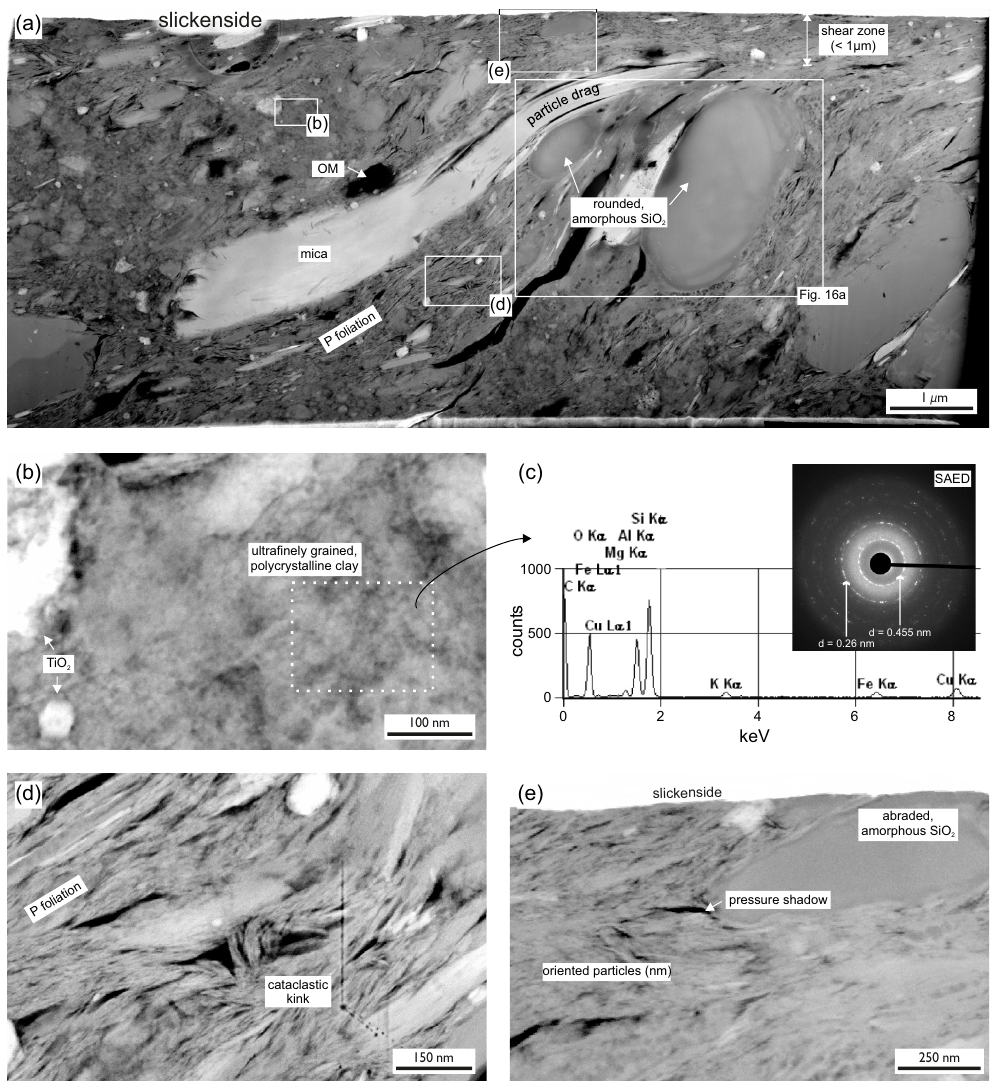
Figure 14. Microfabric of gouge (sample V15-FIBgouge1) visualized with TEM methods. (a) HAADF micrograph containing a gouge- internal micrometer-thin shear zone (e) ; P foliation (d) ; pores in pressure shadow regions (e) ; cataclastic kink (d) ; rounded, amorphous SiO 2 grains (also Fig. 16), a dragged mica and unresolvable small, ultrafinely grained gouge matrix (b) . (c) EDX and selected area electron diffraction from the region shown in panel (b) , indicating that the matrix is polycrystalline clay. See text for